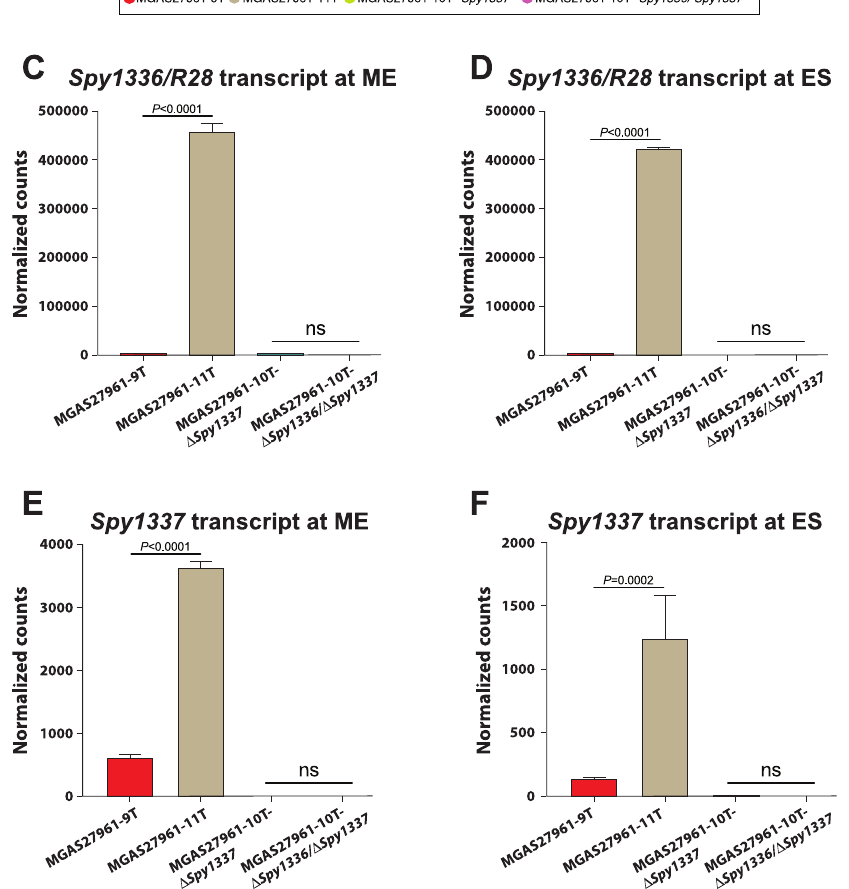
Fig 4. Transcriptome analysis of parental and isogenic mutant strains. RNAseq was performed on isogenic mutant strains MGAS27961-9T, MGAS27961-11T, MGAS27961- Δ Spy1337 , and MGAS27961-10T- Δ Spy1336/ Δ Spy1337 using three biological replicates per strain at two phases of growth: mid-exponential (ME) and early-stationary (ES). Principal component analysis shows distinct clustering of isogenic mutant strains at the (A) ME and (B) ES phases of growth. Strain MGAS27961-11T clusters away from the isogenic strains with mutations that decrease (MGAS27961- 9T) or eliminate expression of Spy1336/R28 and/or Spy1337 (MGAS27961- Δ Spy1337 and MGAS27961-10T- Δ Spy1336/ Δ Spy1337) . (C and D) At both ME and ES, transcript levels of Spy1336/R28 for strain MGAS27961-11T were significantly higher compared to strain MGAS27961-9T. At both phases of growth, no detectable Spy1336/R28 transcript was observed in the isogenic knockout strains (MGAS27961- Δ Spy1337 and MGAS27961-10T- Δ Spy1336/ Δ Spy1337 . (E and F) Similarly, at both ME and ES, transcript levels of the gene Spy1337 were significantly higher in MGAS27961-11T compared to strain MGAS27961-9T. Mean transcript levels are plotted and error bars represent standard deviation. P values were calculated using one-way ANOVA with Tukey’s multiple comparison test.